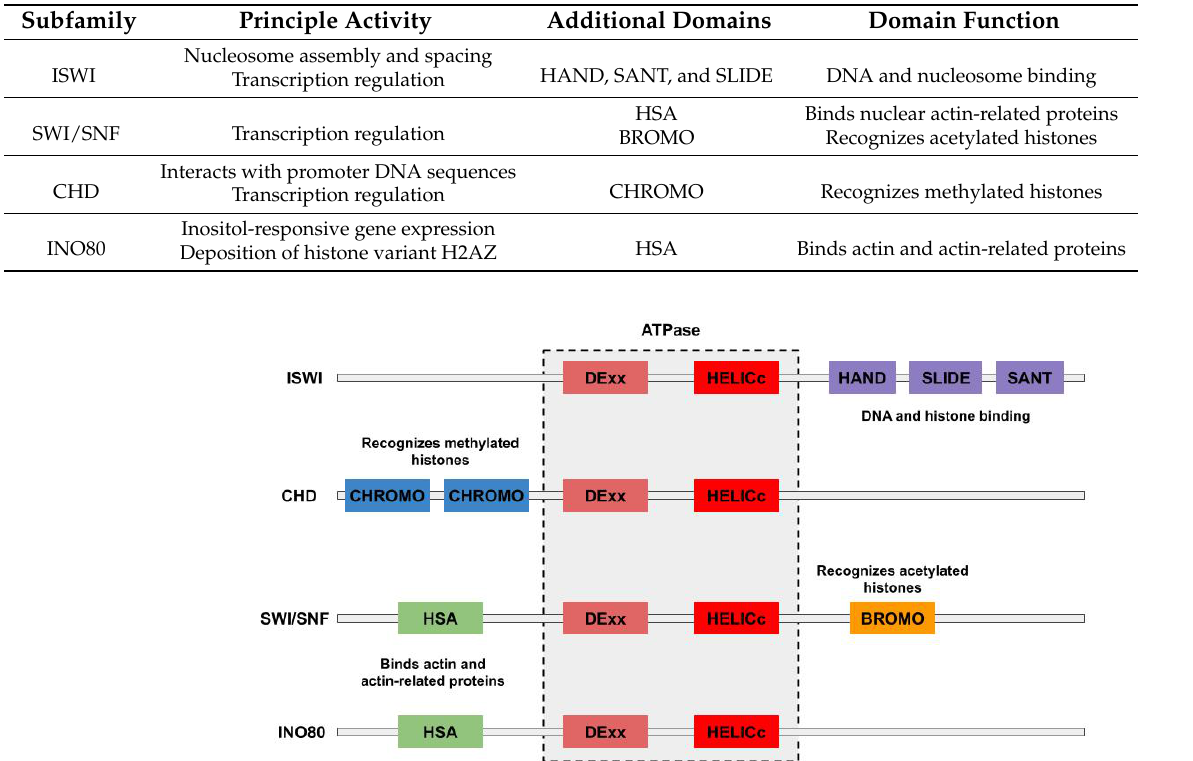
Table 1. Subfamilies of chromatin remodelers.